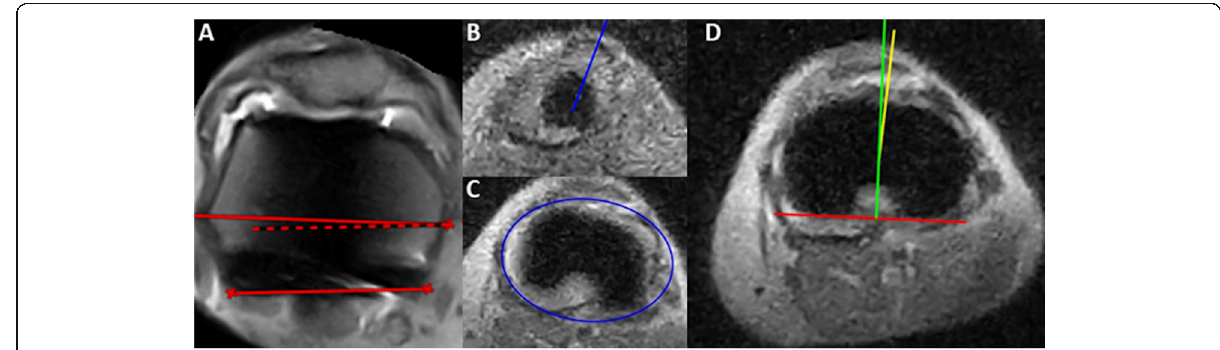
Fig. 4 Rototional malalignment of the TKA. a ) shows 3.3 0 of internal rotation of the femoral component of patient 3, measured as the angle between the posterior condylar axis and the surgical transepicondylar axis. b - d ) show 4.4 0 tibial component rotation, measured in accordance with the Berger protocol, wherefore b shows the top of the tibia tuberosity, which is connected with the centre of the tibia determined in c . In d , the angle between the yellow line and the green line perpendicular on the tangent of the tibia plateau of the tibial component (red) was calculated as 4.4 0 tibial component